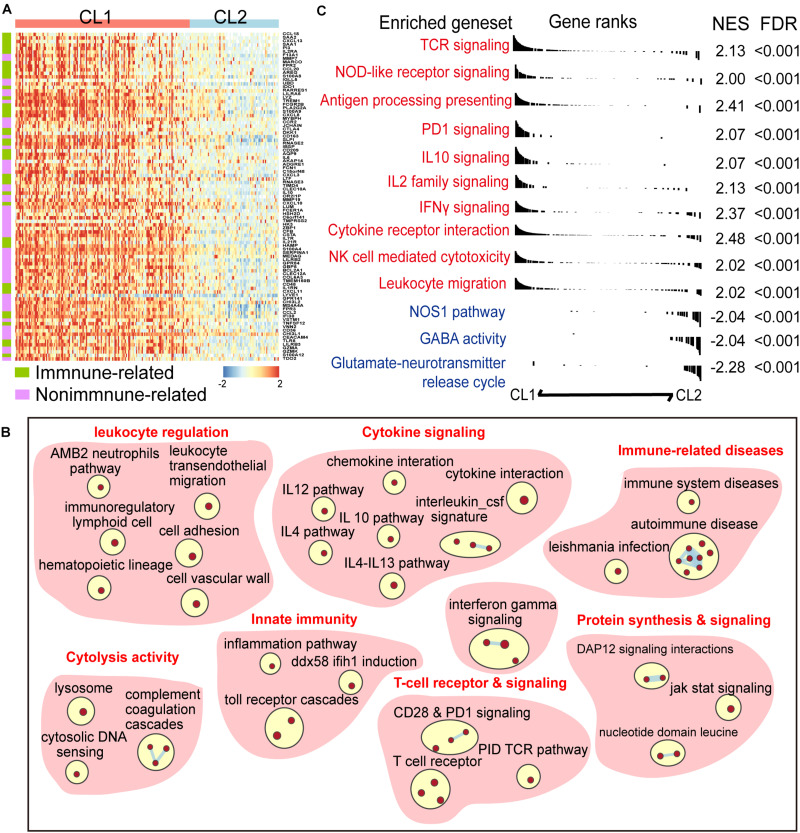
A panel of six-CARD genes associates with activation of immune pathway. (A) Top upregulated genes in CL1 versus CL2 (log2 fold change >2 and FDR < 0.01). Genes were sorted by the fold change and annotated using Immport database. (B) Overview of gene sets enriched in CL1 versus CL2 [normalized enrichment score (NES) >2 and FDR < 0.01]. (C) Differences in canonical gene sets between CL1 and CL2.